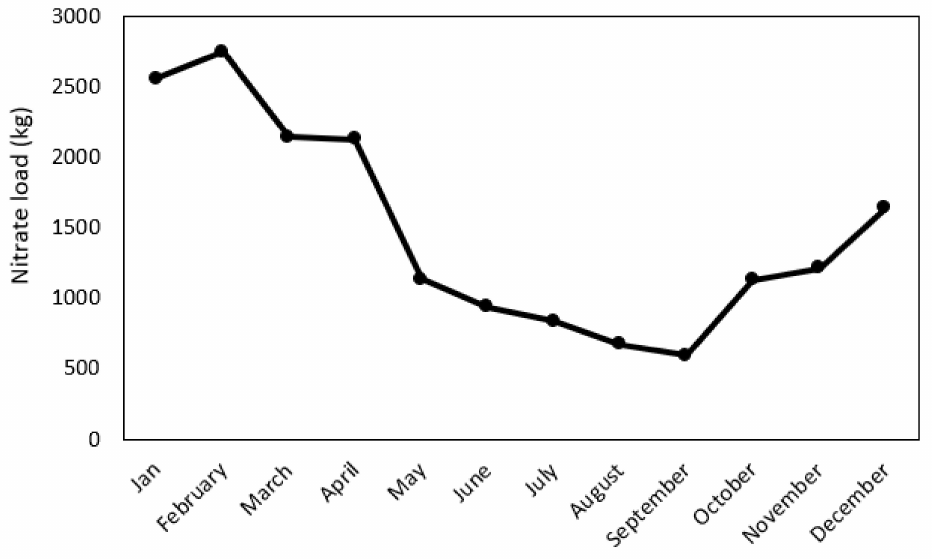
Figure 8. The average nitrate load output the Tajan watershed during the months of the